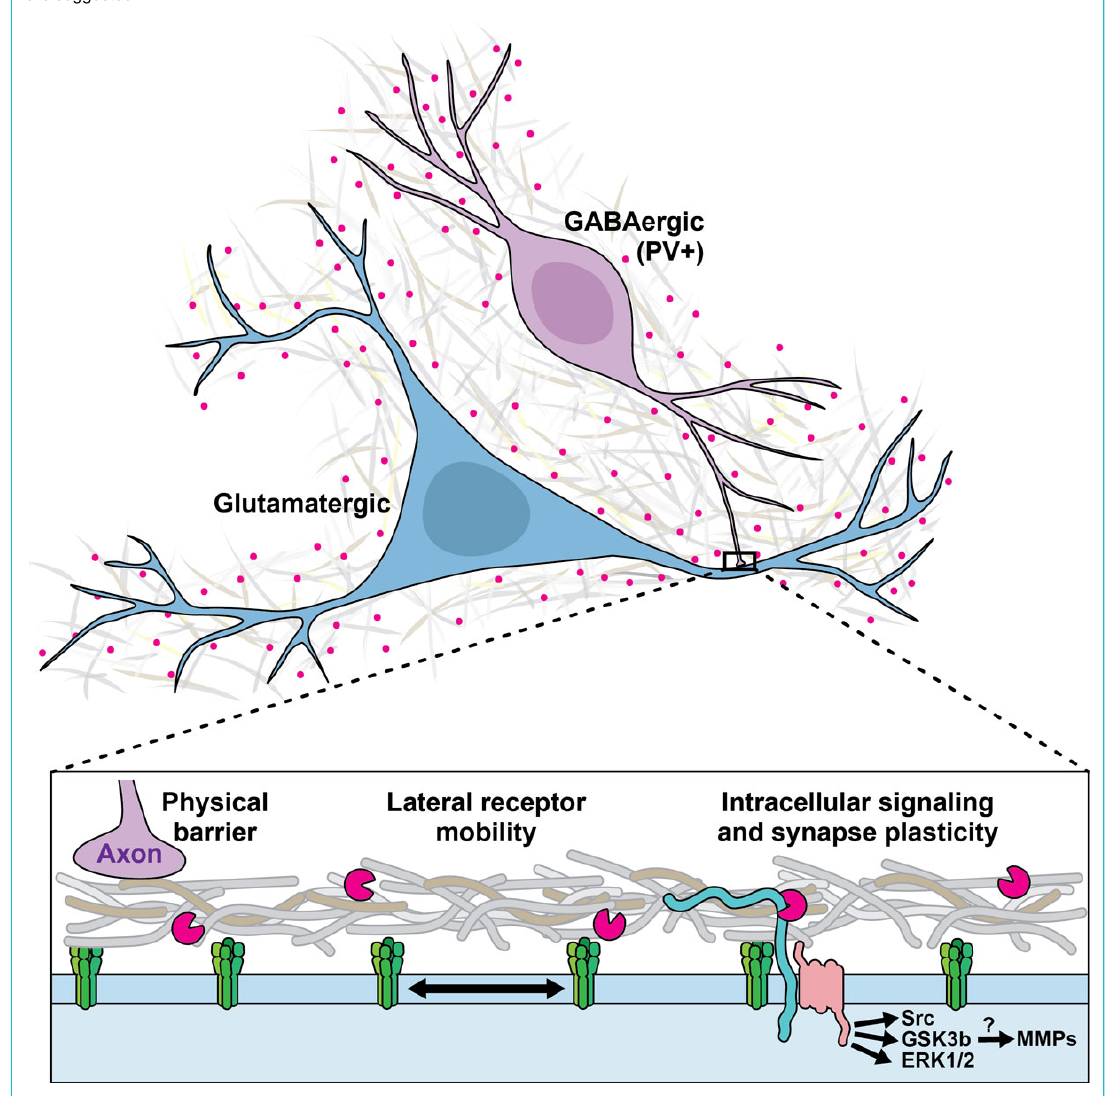
Figure 1: ECM and synaptic plasticity regulation. Different mechanisms underlying the impact of ECM components on synaptic plasticity are